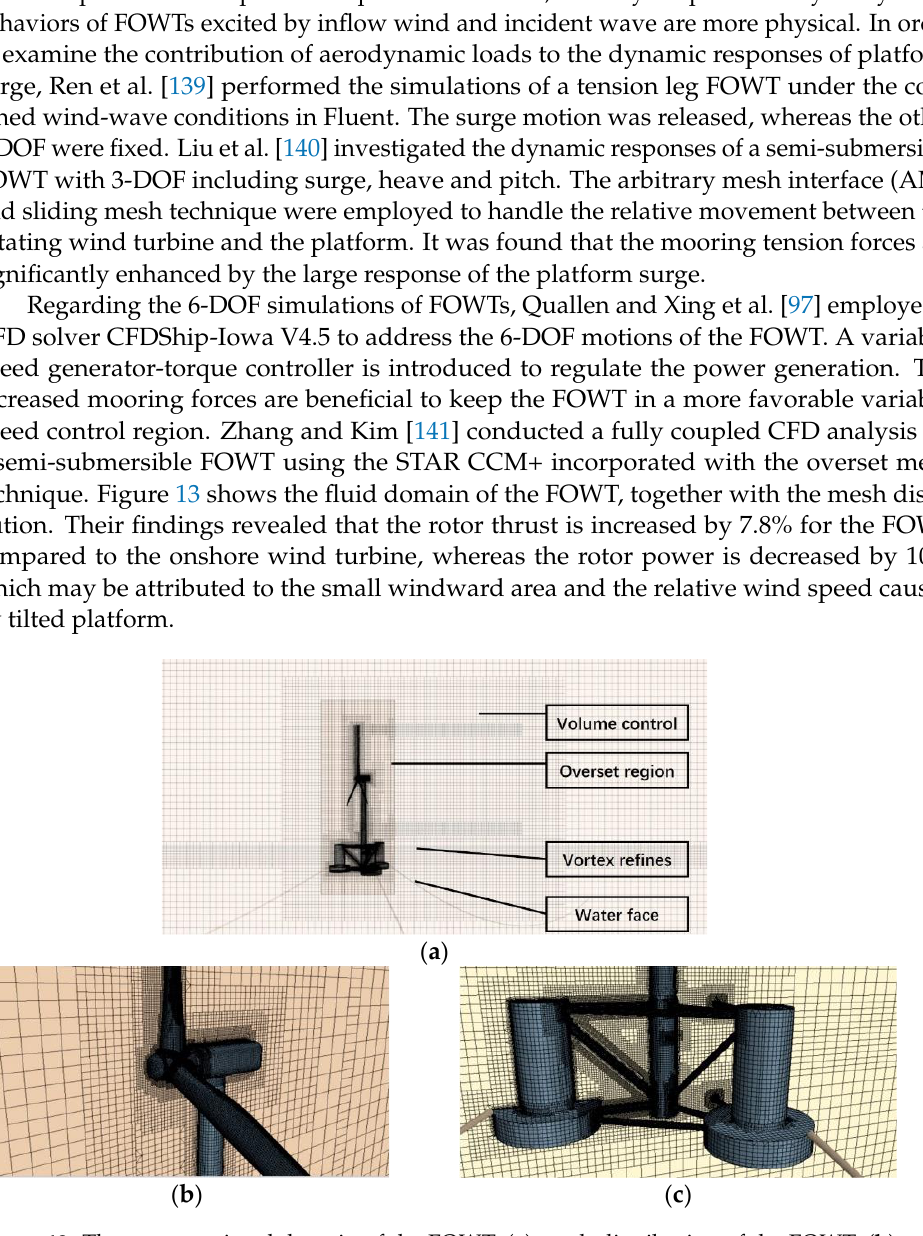
Figure 13. The computational domain of the FOWT: ( a ) mesh distribution of the FOWT; ( b ) mesh around wind turbine; ( c ) mesh around platform [141].